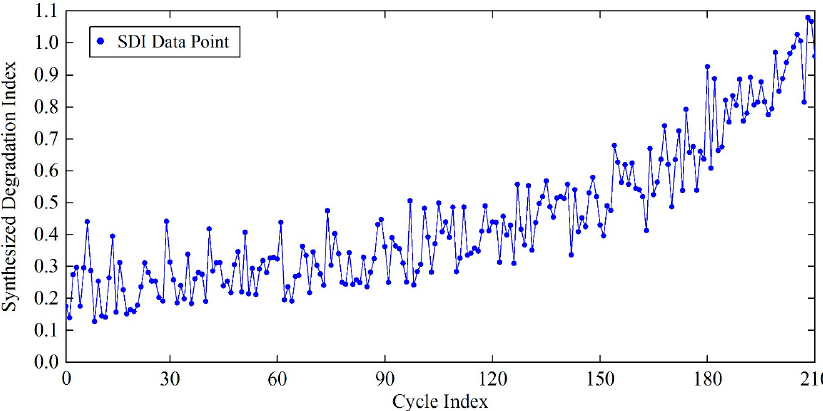
Figure 4. The constructed synthesized degradation index (SDI) series based on the multi-dimensional sensor data.